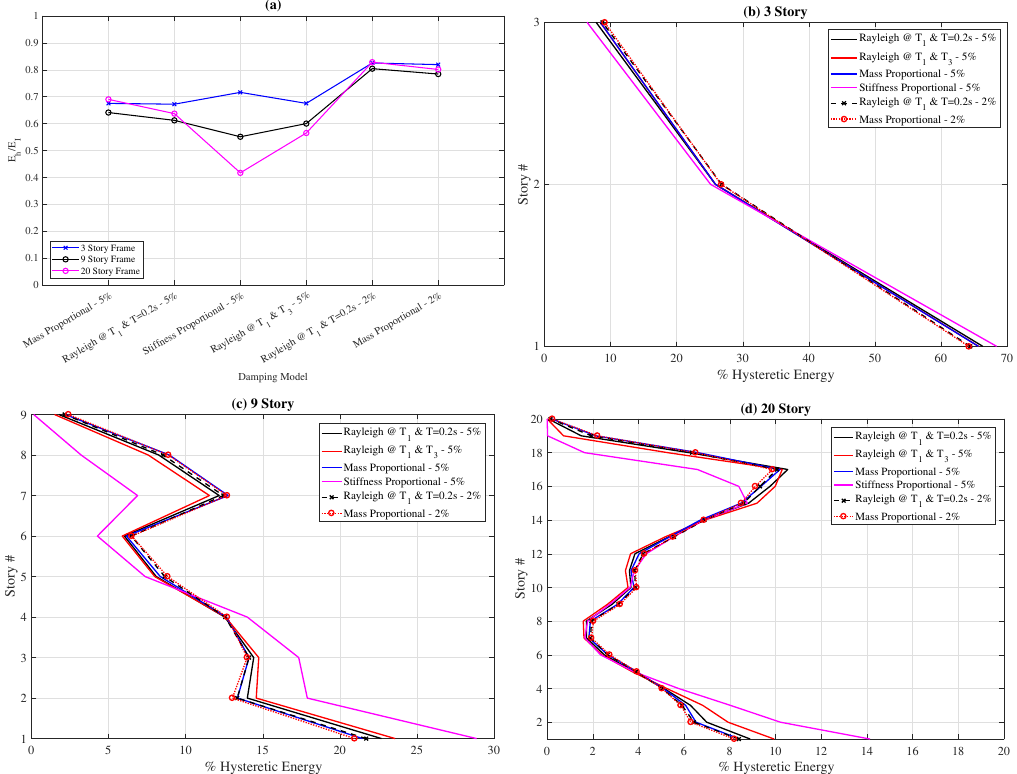
Figure 7. Effect of damping models on ( a ) the total hysteretic energy demand and the distribution of hysteretic energy demand over the height of the ( b ) 3-story ( c ) 9-story and ( d ) 20-story